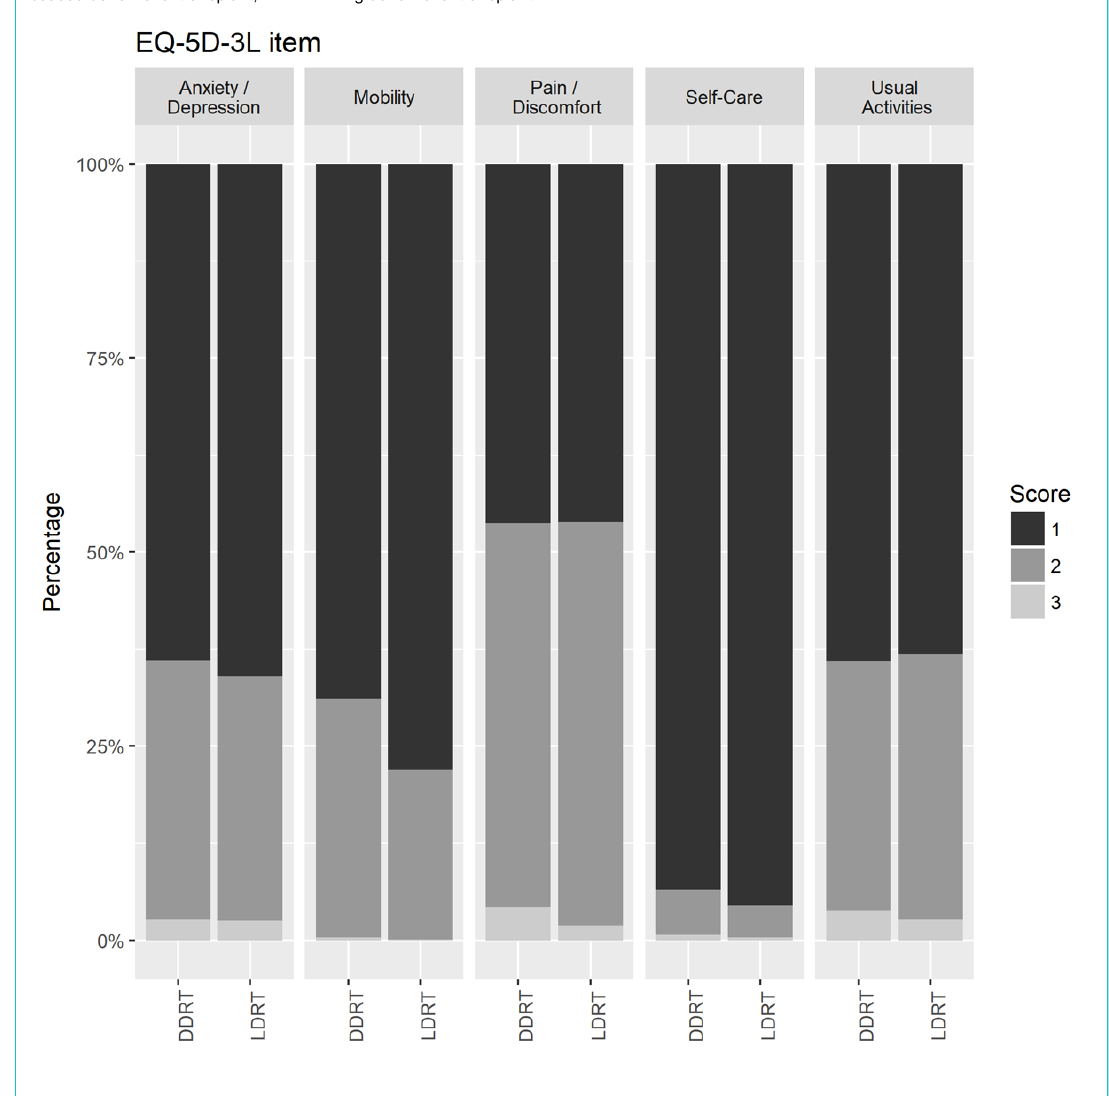
Figure 3: Bar plot of percentages of transplant recipients of EQ-5D-3L scores by item for 1780 DDRT and LDRT transplant candidates before transplantation. For 205 recipients response was missing. Score 1 = no problems, 2 = some problems, 3 = severe problems. DDRT = de- ceased donor renal transplant; LDRT = living donor renal